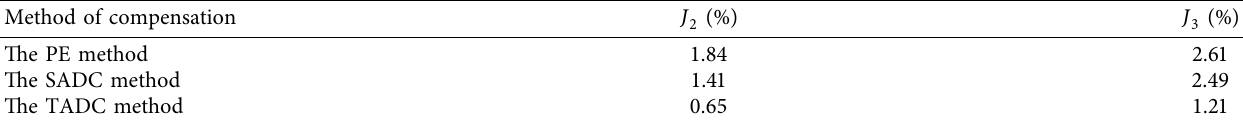
Table 2: RTHS evaluation index with 3 Hz sine signal